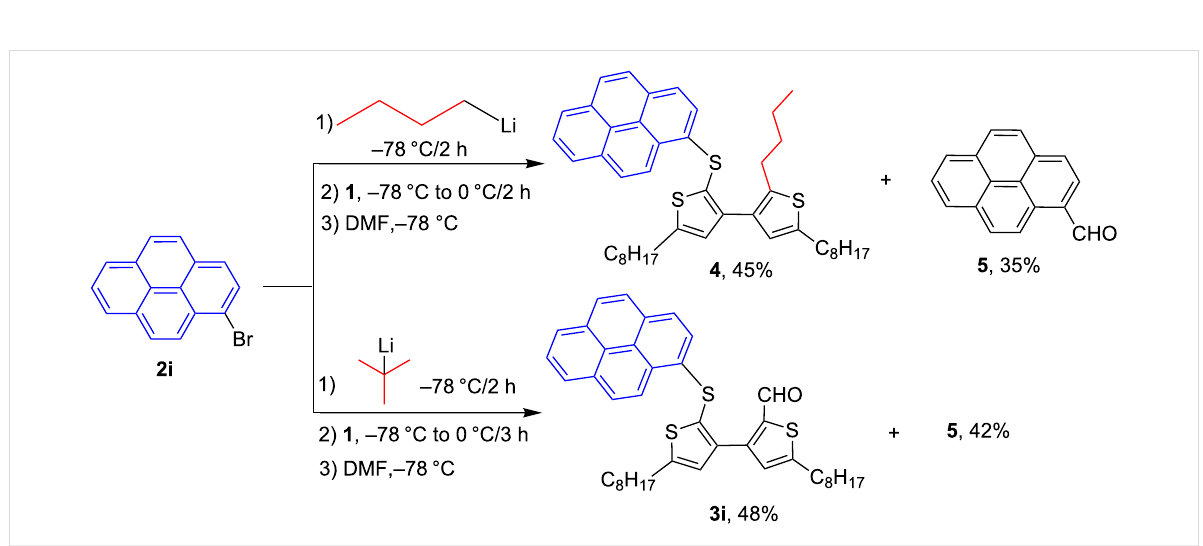
Scheme 2: The ring-opening reaction of 1 in the presence of n -BuLi and t -BuLi employed for metal–halogen